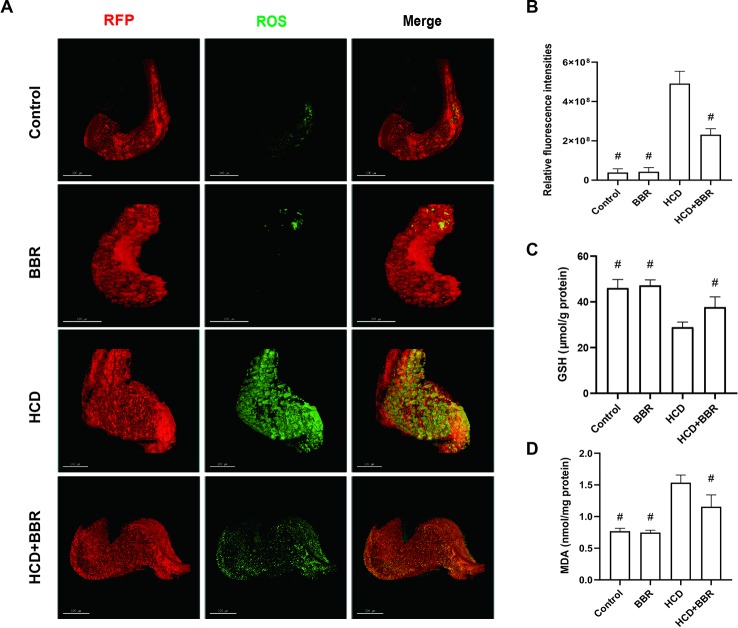
Effects of berberine (BBR) on the hepatic oxidative stress in high-cholesterol diet (HCD)-induced zebrafish larvae. (A) Liver volume rendering of reactive oxygen species (ROS) staining showed that BBR (5 μM) attenuated hepatic ROS level in HCD-induced Tg (fabp10a: dsRed) zebrafish. ROS generation in the Tg (fabp10a: dsRed) zebrafish liver treated with HCD. Hepatic ROS were detected with CellROX® Green Reagent. Bar = 100 μm. (B) Quantitative analysis of ROS throughout the entire zebrafish liver. Effects of BBR (5 μM) on the glutathione (GSH) (C) and malondialdehyde (MDA) (D) levels in HCD-induced zebrafish larvae. #Compared with the HCD group, P < 0.05.